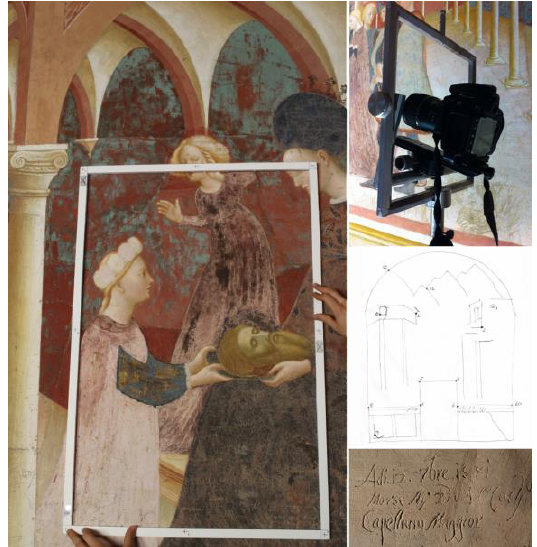
Figure 4: Photographic documentation of graffiti and manual sketches of measurements Figure 5: Laser scans (above), generative lines of the structure (middle), 3D model composed by digital surfaces A specific plug-in (Point Cloud) for point clouds produced by laser scanners was used in order to better manage them. A series of different section lines were traced with polylines alongside the major generative lines of the structure. Thanks to these polylines, the respondent wall surfaces were digitally generated, with a high correspondence with laser scans and real object (fig . 5). For what concerns the photographic documentation, a series of rectified images of single walls were created. Since most of the inner wall are sub-planar surface, operations of rectification aimed to minimize distortions were successful. The different rectified images were successively assembled together in three-dimensions, using topographic measurements as reference and recreating the spatial disposition of walls. Two large portions of the southern wall, where there are most of the ancient graffiti, were also selected for a more detailed documentation. In this case, four different photogrammetric projects were set, two for each wall with different lighting conditions. The image blocks were processed with Agisoft PhotoScan Pro (fig. 6)